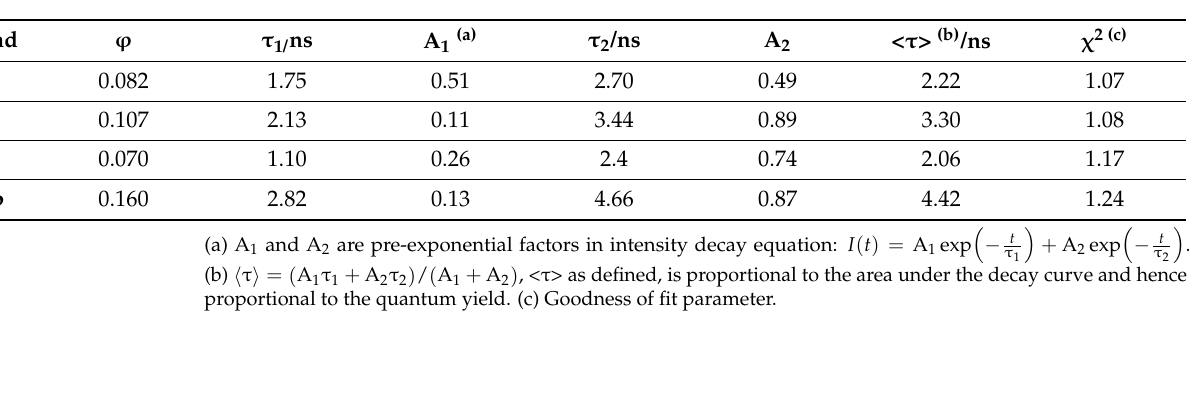
Figure 2. Fluorescence spectra of isoabsorptive aqueous solutions of I – III and L-N-acetyltryptophan (N-AcTrp, λ ex = 280 nm) in 1 cm cuvette ( a ), fluorescence decay traces of I – III at 350 nm ( λ ex = 270 nm), IRF—instrument response function ( b ). Absorption spectra are given in Figure S1 (Supplementary Materials). Table 1. Fluorescence quantum yields ( ϕ ) and lifetimes ( τ ) for studied peptides I – III at 296 K in aqueous